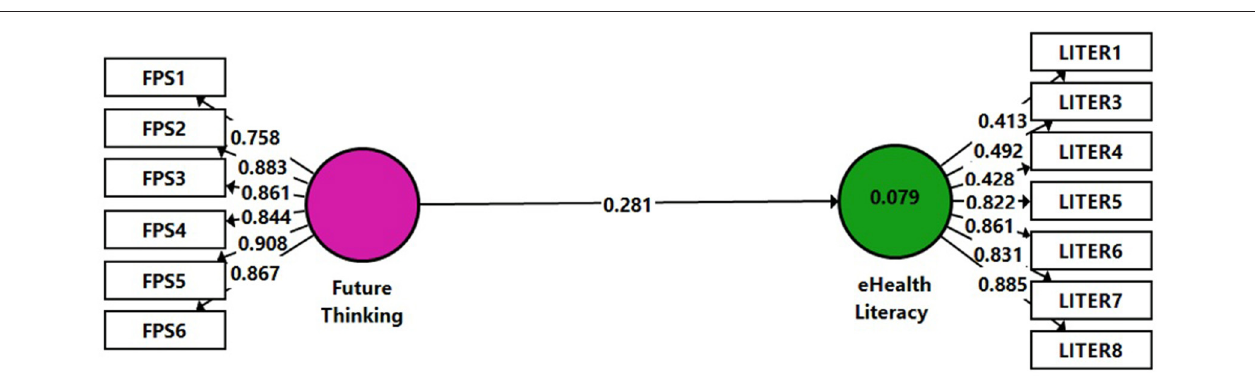
FIGURE 3 | Model 2. Analysis results of the examination of H3 by